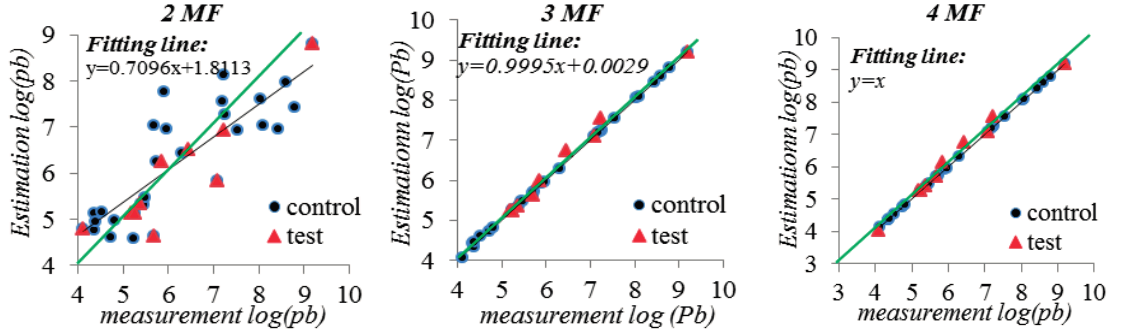
Figure 9. Scatterplot of measured and estimated lead amount with fuzzy neural